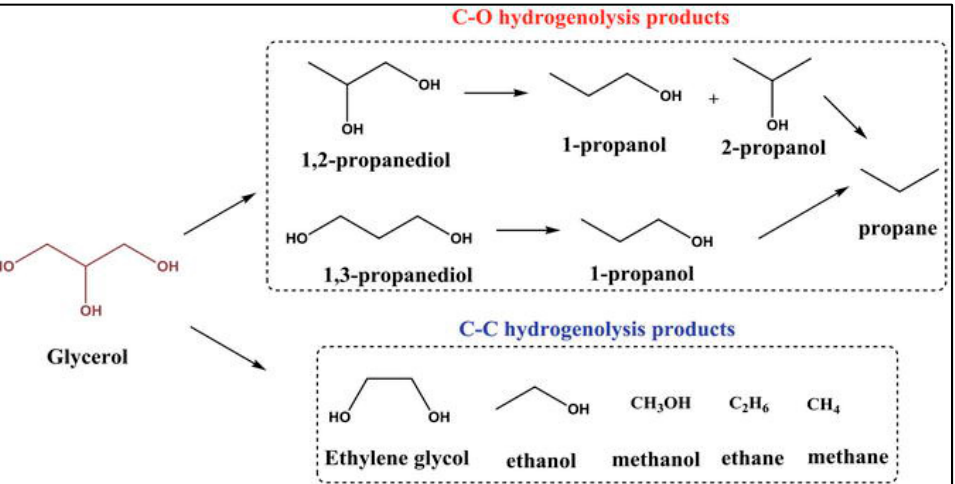
Figure 4. Products obtained from glycerol hydrogenolysis. Reprinted/adapted with permission from Samudrala [90], IntechOpen, 2018.